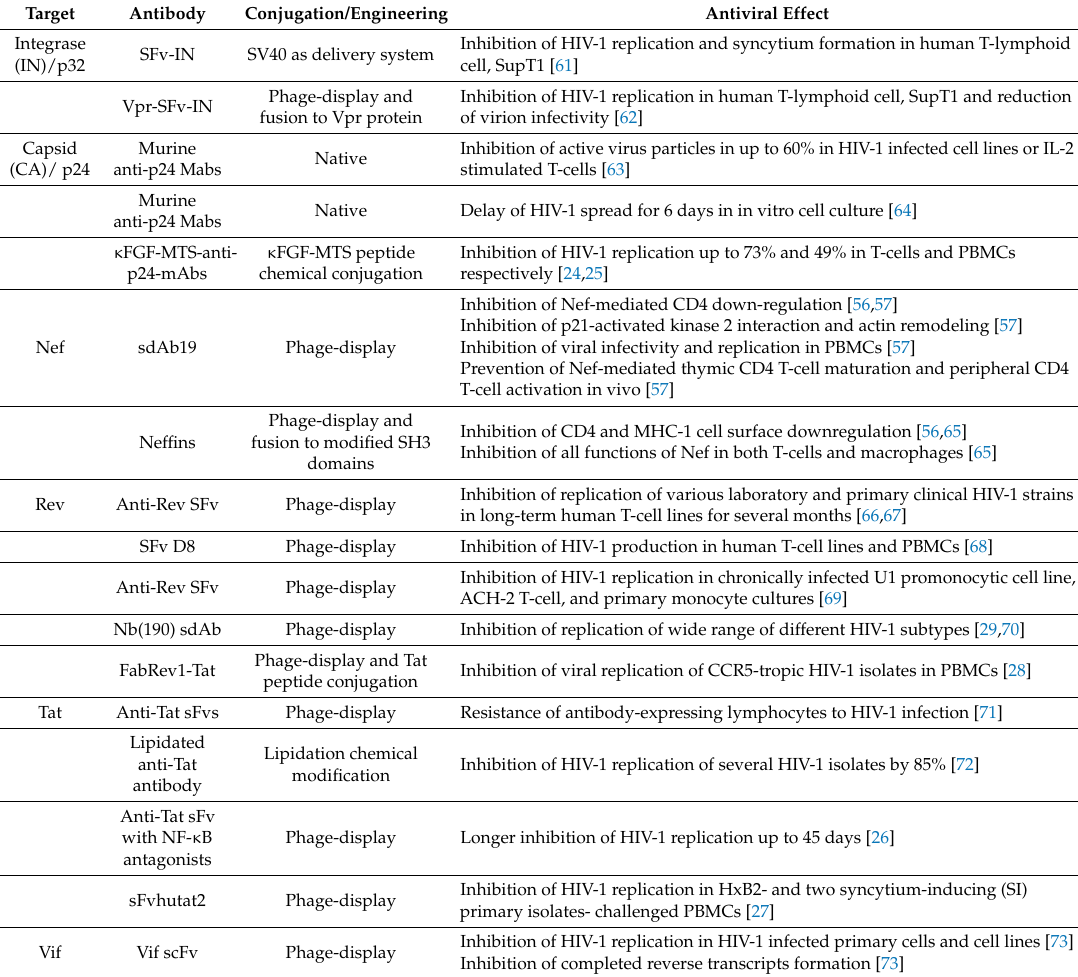
Table 1. Development of therapeutic antibodies against HIV-1 intracellular